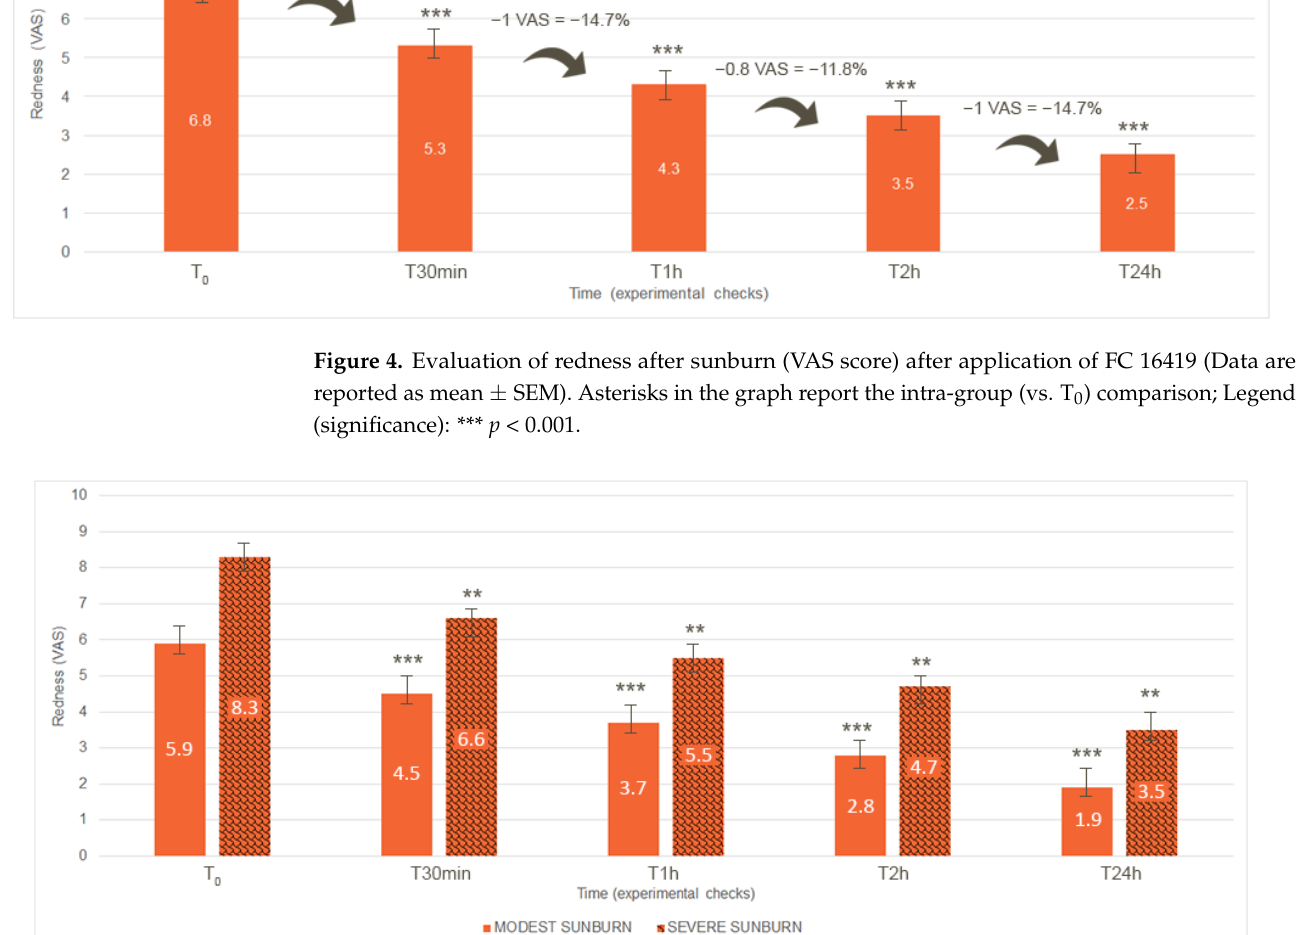
Figure 4. Evaluation of redness after sunburn (VAS score) after application of FC 16419 (Data are reported as mean ± SEM). Asterisks in the graph report the intra-group (vs. T 0 ) comparison; Legend (significance): *** p < 0.001.